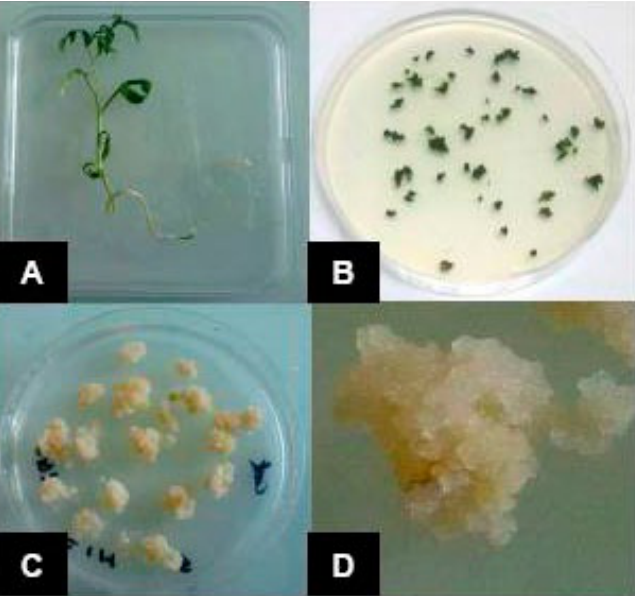
Fig. 1 - Establishment of Cakile maritima calluses. (A) Three-week- old C. maritima seedling grown from sterilized seed. (B) Slices of leaf and rod were finely cut for callus generation. (C) One- month-old calluses derived from rod and leaf slices. (D) Mag- nification of a callus.